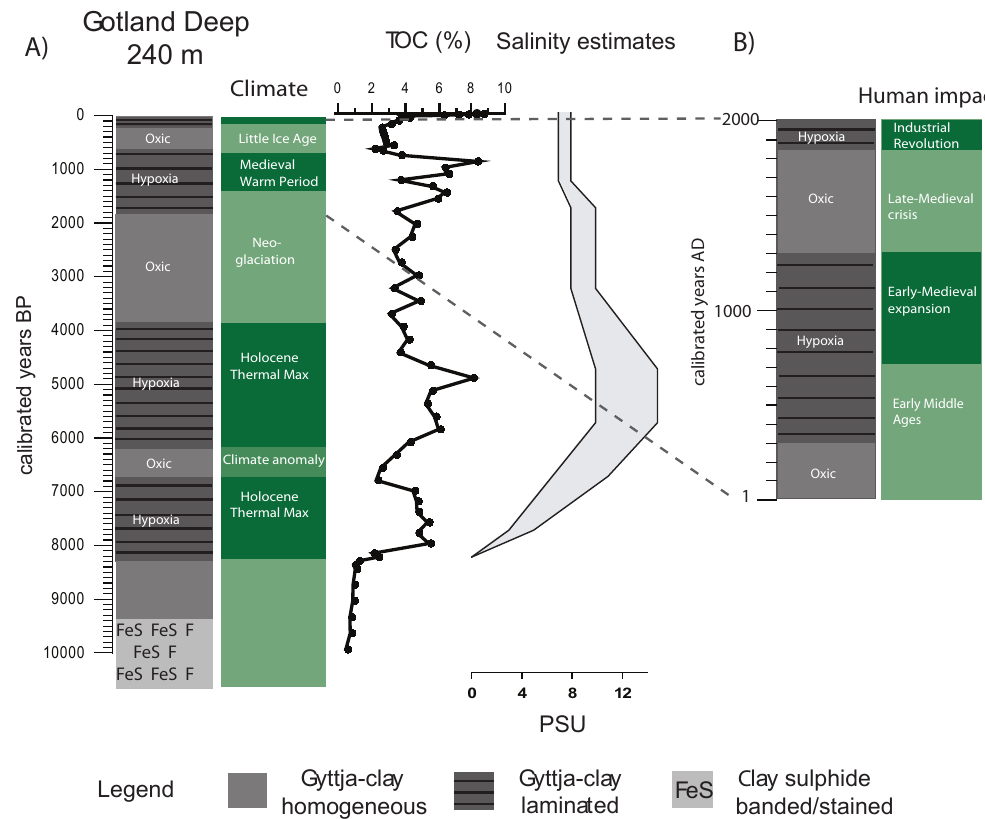
Fig. 2. (A) Figure showing the occurrence of laminated sediments, total organic carbon content (TOC) and salinity estimates, plotted against a calendar year time scale, based on a compilation of sediment records from the Baltic proper (Zill´en et al., 2008). The sediment records suggest that during the last c. 8000calyrBP hypoxia has occurred intermittently in the deeper sub-basins in the Baltic Proper. The hypoxia during the early Littorina Sea (8000–4000calyrBP) coincides with intervals of maximum salinity estimates and high TOC values. Hypoxia during the last two millennia does not correlate to any alterations in salinity but to maximum TOC contents during the Medieval Warm Period (MWP) and the last c.100 years. (B) The figure shows the same sediment records as in (A), but compared to anthropogenic expansion and contraction phases. The coherency between the two latter records suggest that human impact is just a strong potential independent forcing mechanism on increased productivity and hypoxia as climate changes during the late Holocene history of the Baltic Sea. Note that due to the poor chronological control associated with Baltic Sea sediments the age error estimates of the periods of hypoxia the last 2000 years are approximately ± 500 years (Zill´en et al., 2008). The non-overlap between the period of hypoxia centered at c.1000AD and the intervals of climate/human impact changes may thus be due to dating